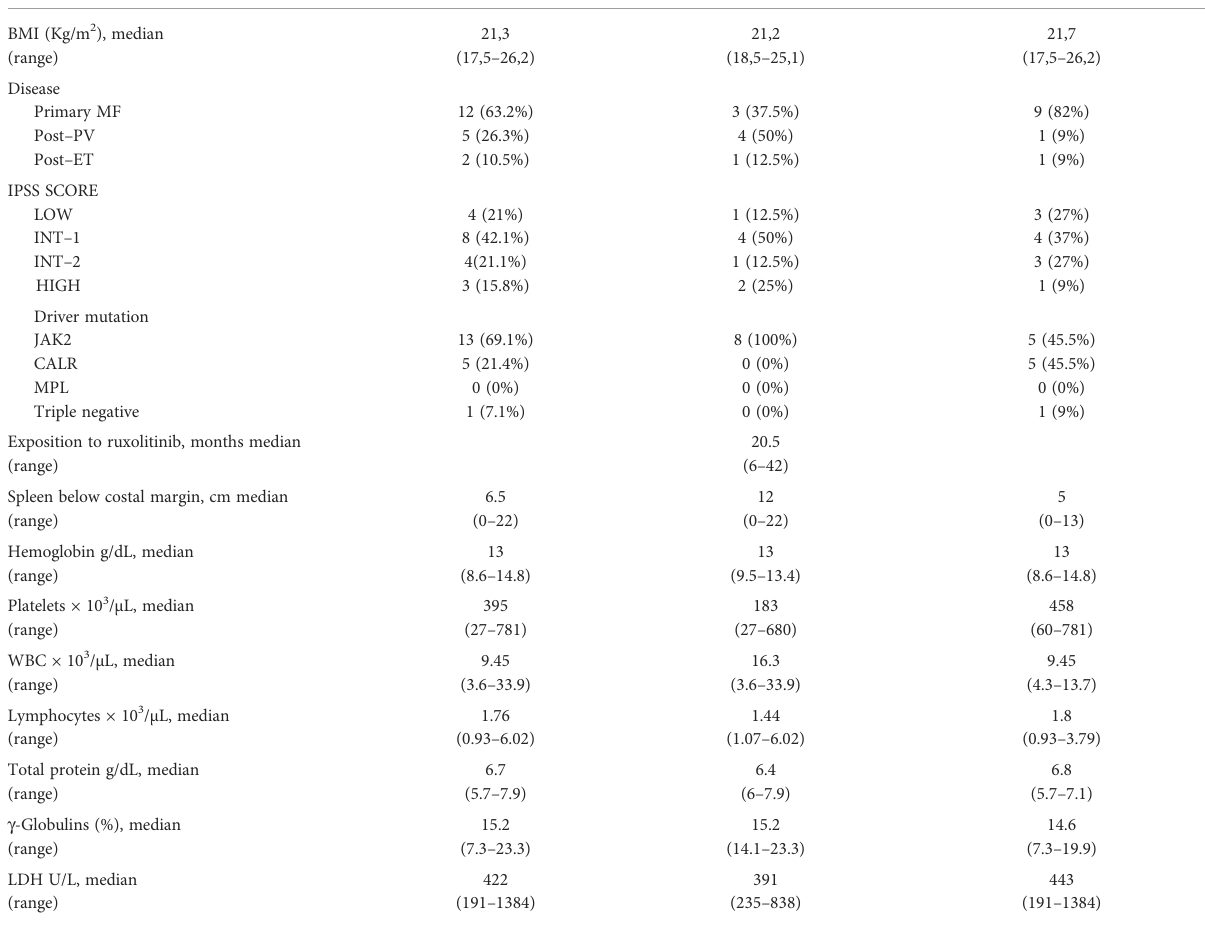
TABLE 2 Clinical characteristics of MF patients before the third dose of mRNA vaccine anti SARS-CoV-2. Clinical